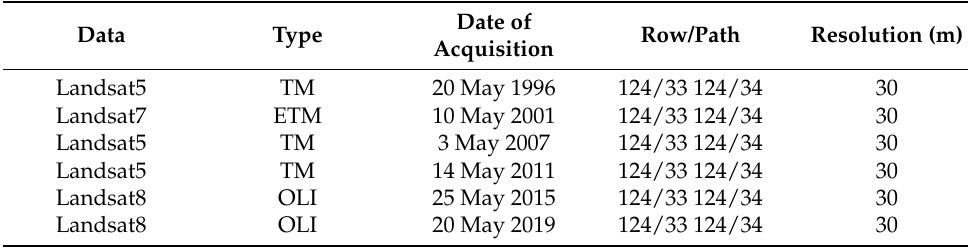
Table 1. Remote sense statistic parameters.